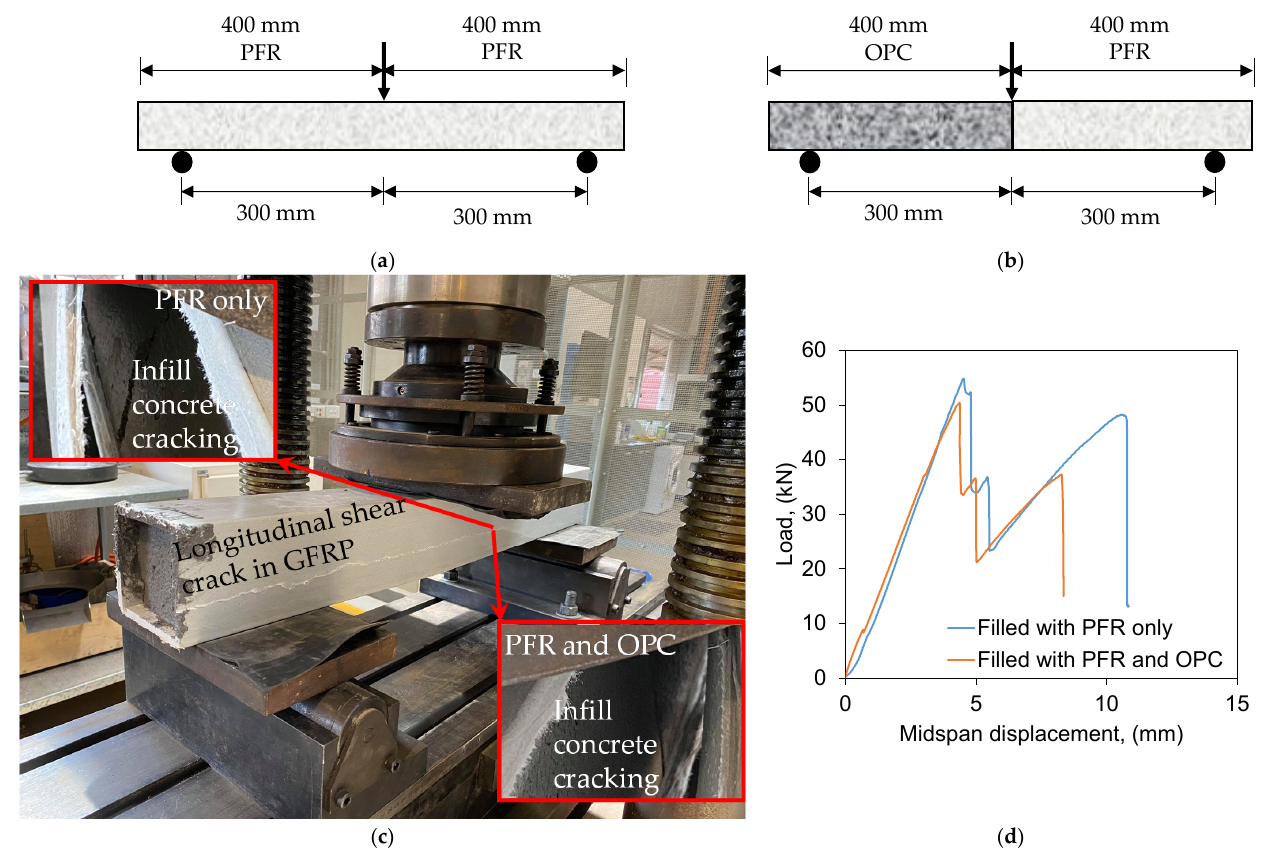
Figure 8. Effect of joint between OPC and PFR. ( a ) FRP tube filled with PFR only. ( b ) FRP tube filled with PFR and OPC. ( c ) Failure mode. ( d ) Load-displacement plot.